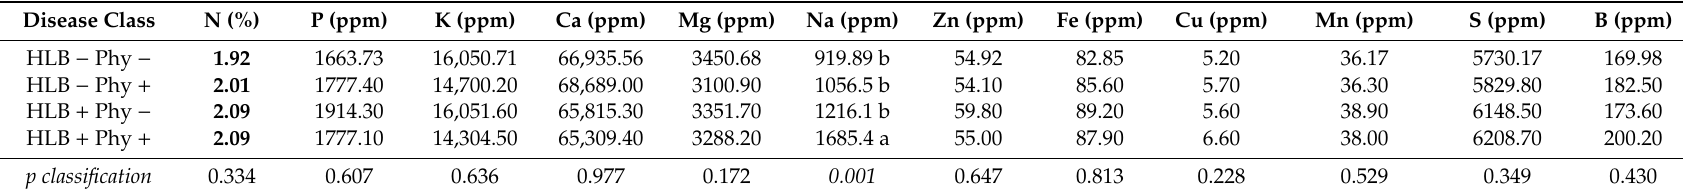
Table 1. Nutritional analysis of trees in di ff erent disease classifications. Di ff erent letters represent significant di ff erences as determined by Students t ( p = 0.05). Bold values indicate nutrient